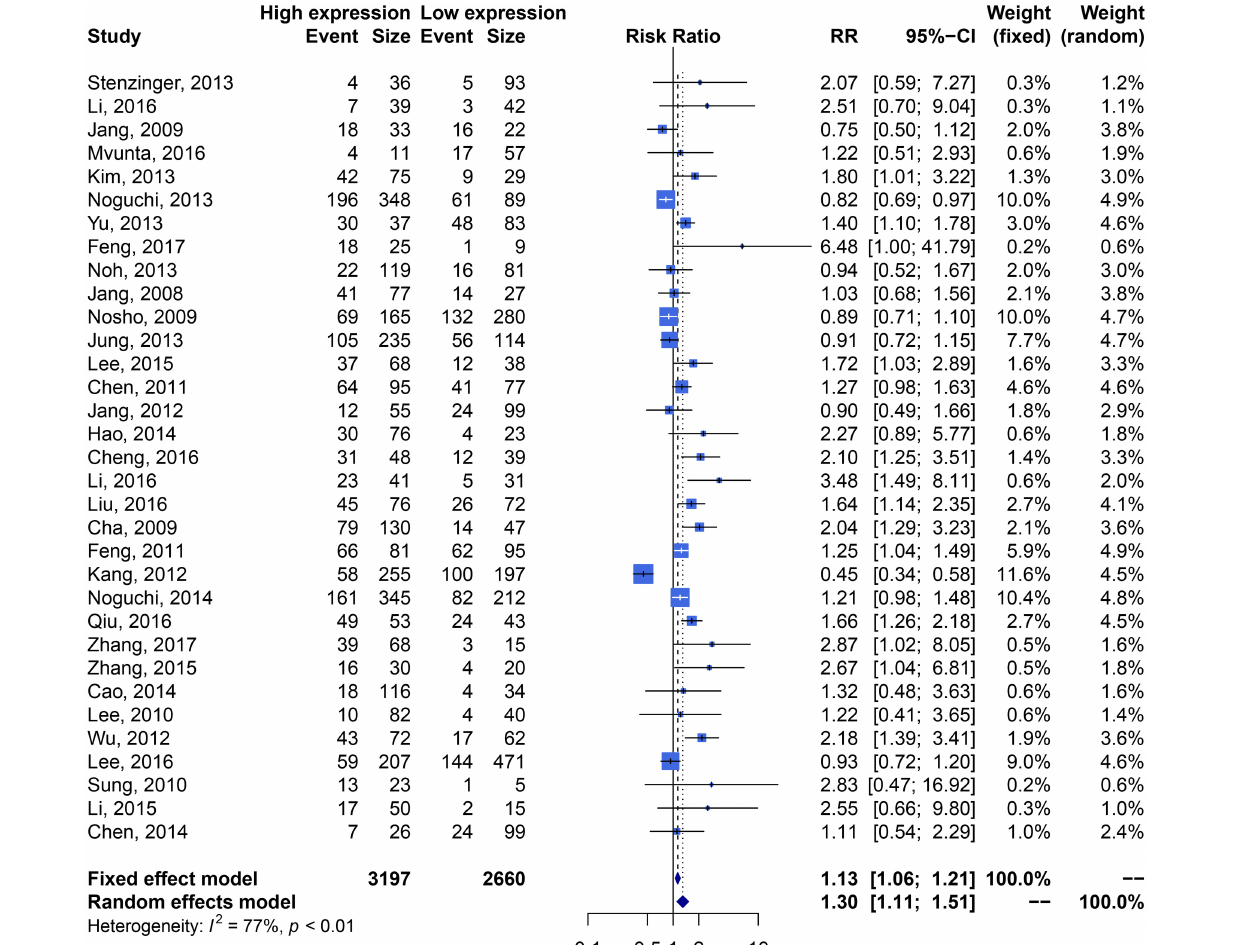
3.830, 95% CI: [1.445, 10.154], P = 0.0069, I 2 = 0%), but not in Asian population ( n = 12, RR: 1.422, 95% CI: [0.913, 2.217], P = 0.1198, I 2 = 72.85%) ( Supplementary Figure 5B